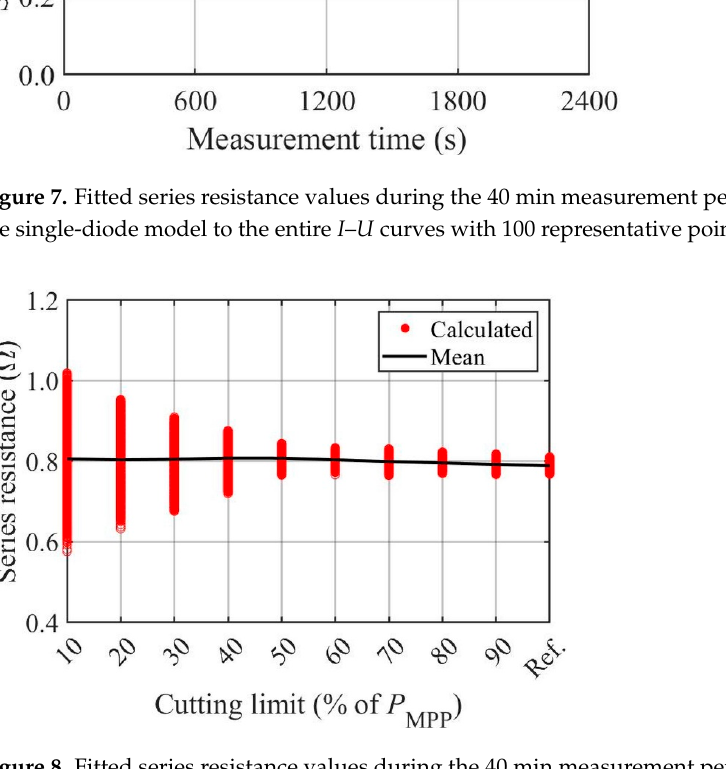
Figure 7. Fitted series resistance values during the 40 min measurement period obtained by fitting the single-diode model to the entire I – U curves with 100 representative points. Figure 8. Fitted series resistance values during the 40 min measurement period as a function of the cutting limit based on MPP power. Table 2. Statistical quantities of the fitted series resistance values for different cutting limits based on MPP power during the 40 min measurement period.